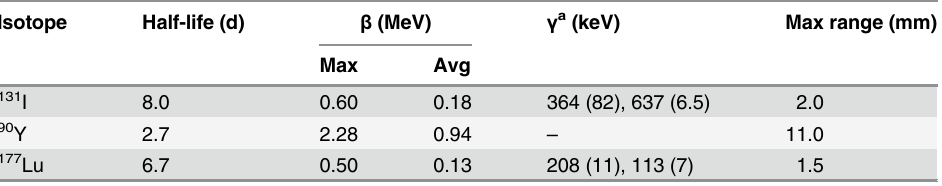
Table 1. Properties of selected therapeutic beta